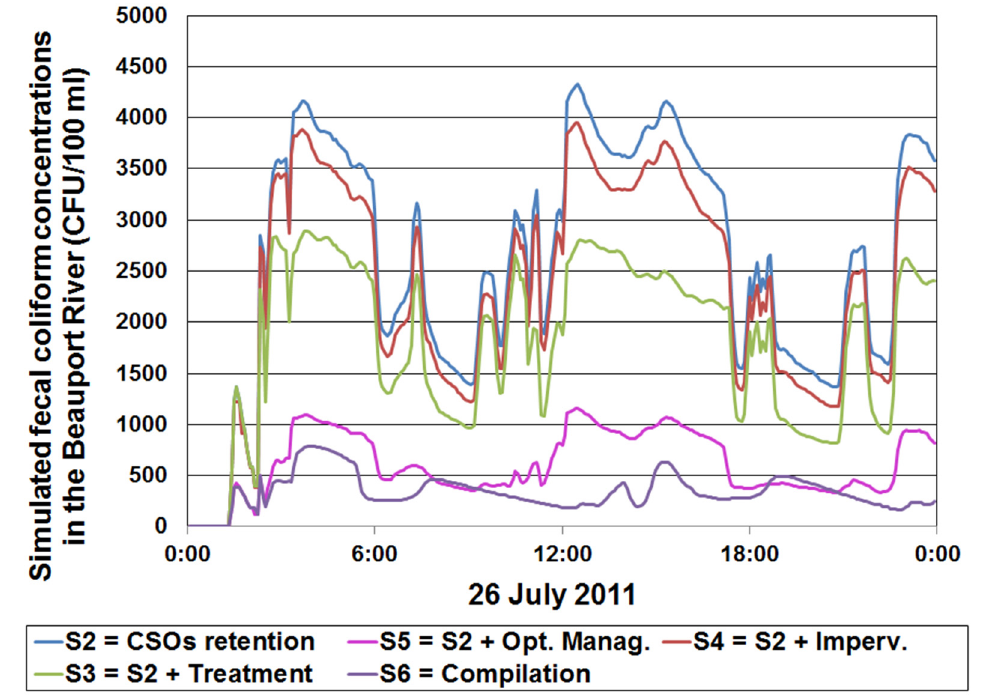
Figure 9. Simulation of water quality in the Beauport River on 26 July 2011 according to various